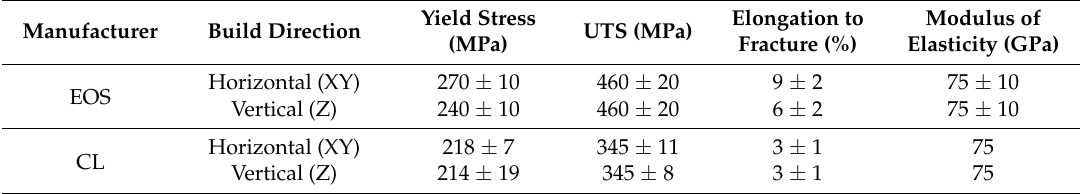
Figure 1. Schematic of scanning strategies by ( a ) bi-directional, EOS M280; and ( b ) chessboard, CL X line 1000R. Table 4. Quasi-static tensile mechanical properties, as reported by manufacturers [27,28].